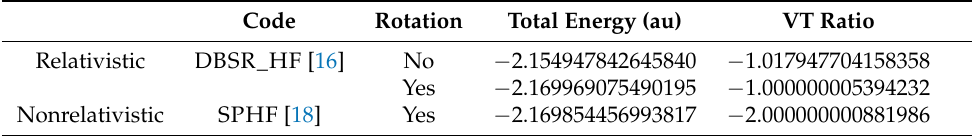
Table 1. Results from different codes and methods applied to He 1 s 2 s 1 S